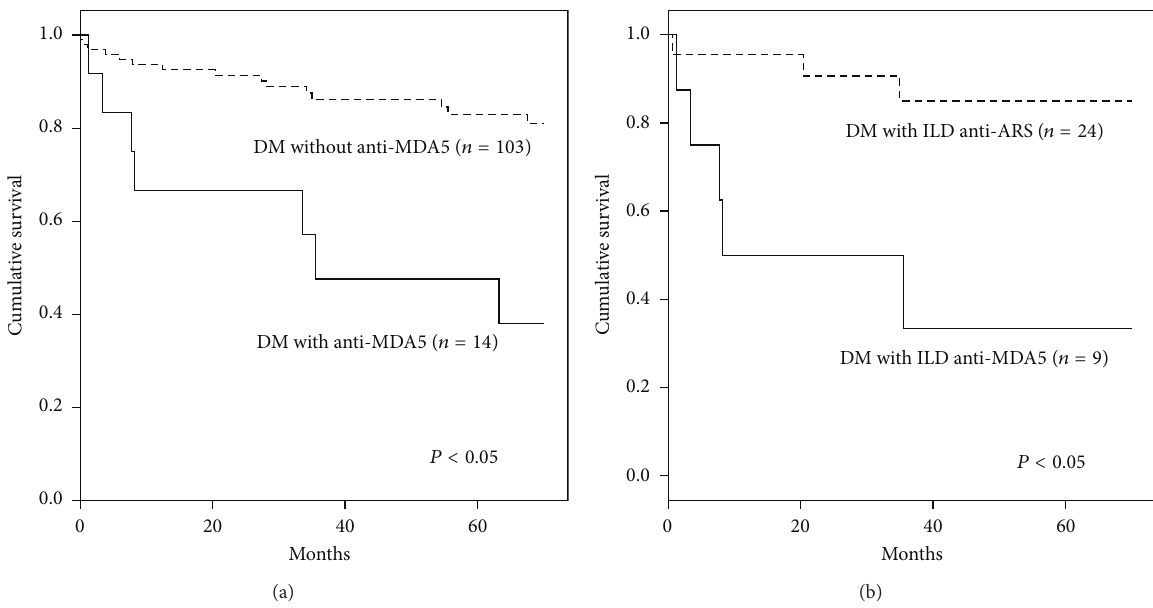
Figure 3: Cumulative 70-month survival rates for DM patients with and without anti-MDA5 antibody (a) and for DM patients with ILD associated with anti-ARS or anti-MDA5 (b). The 70-month cumulative survival rates were calculated using the Kaplan-Meier test. The log- rank test was also used to compare survival rates. ARS: aminoacyl-tRNA synthetase; DM: dermatomyositis; ILD: interstitial lung